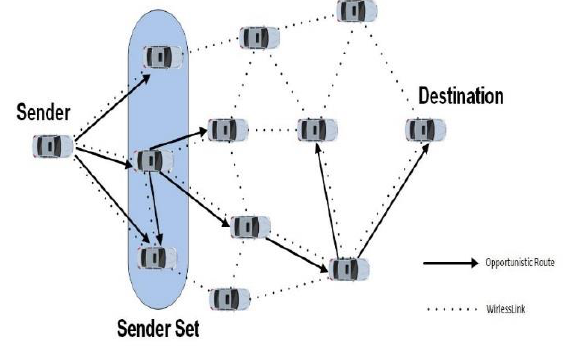
Figure 1. An example of packet forwarding using opportunistic